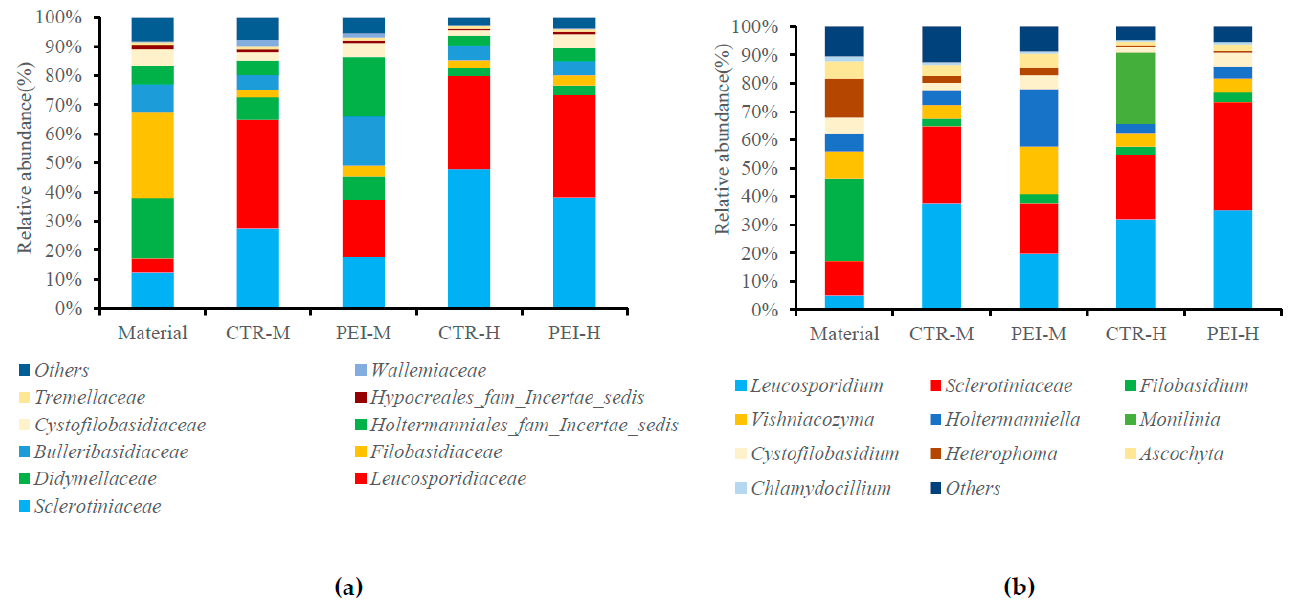
Figure 2. Relative abundances of the 10 most abundant family and genus of the fungal microbiota of pre-ensiled crops and silages prepared from alfalfa silage. ( a ) Family- and ( b ) genus-level bacterial community in alfalfa silage. M—alfalfa ensiled at medium DM; H—alfalfa ensiled at high DM; CTR—no additive; PEI—inoculated with Purina FI Enhance Inoculant (PEI, Purina Animal Nutrition LLC, Arden Hills, MN, USA) ( Pediococcus acidilactici , Enterococcus faecium and Lactobacillus plantarum ); M—medium DM alfalfa silage; and H—high DM alfalfa silage.